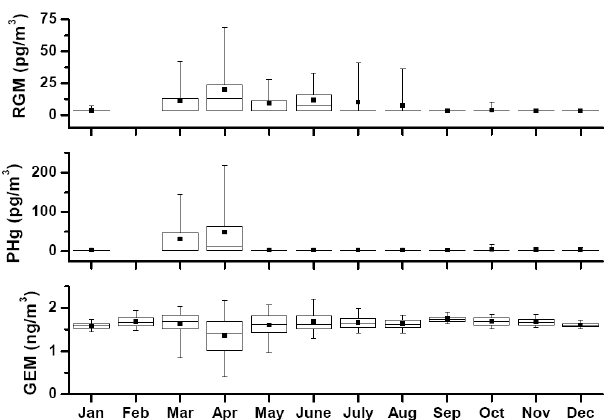
Fig. 3. Seasonal distribution of the GEM, RGM and PHg con- centrations for 2007 and 2008. The box represents the monthly 25th and 75th percentiles of the complete dataset, the line repre- sents the monthly median concentrations, and the black square rep- resents the monthly average concentrations. The whiskers represent the monthly 10th and 90th percentiles of the complete